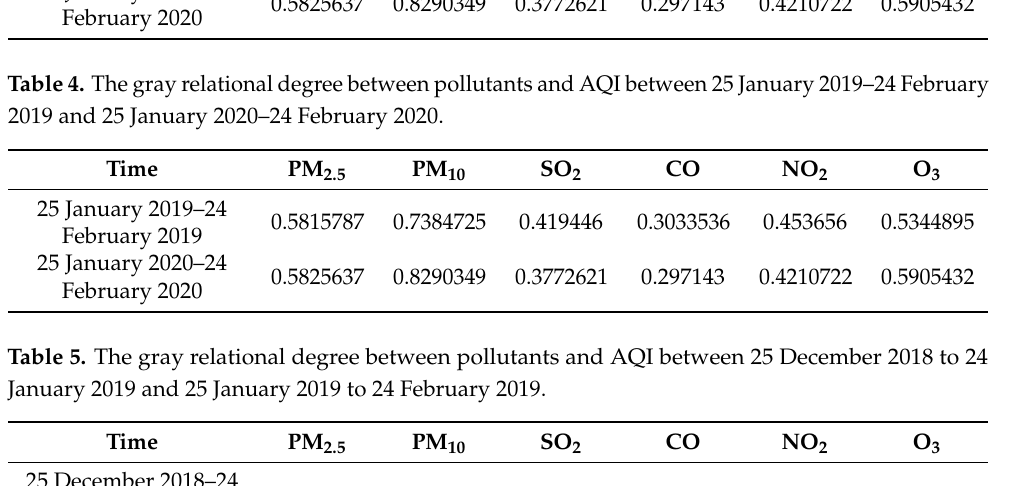
Time PM 2.5 PM 10 SO 2 CO NO 2